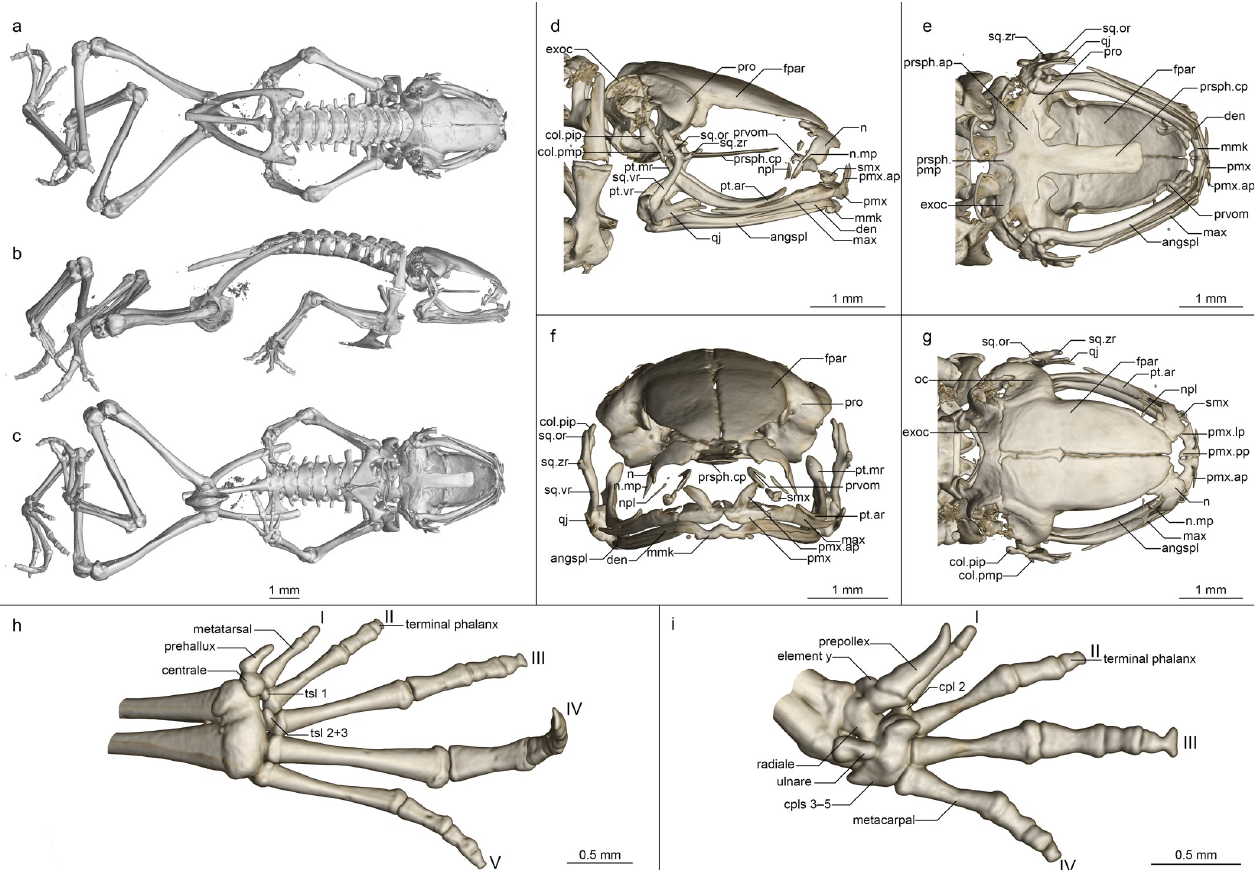
Fig 13. Osteology of Anodonthyla eximia sp. nov. holotype (ZMA 20246). (a-c) Whole skeleton in (a) dorsal, (b) lateral, and (c) ventral view. (d-g) Skull in (d) lateral, (e) ventral, (f) anterior, and (g) dorsal view. (h) Foot in ventral view. (i) Hand in ventral view. For abbreviations, see Fig 6. small, indistinct, single; inner metacarpal tubercle large and distinct, bulging outward strongly, underlain by cultriform prepollex; hand without webbing; all fingers short, first highly reduced and only marginally longer than the prepollex; relative length of fingers 1 < 2 = 4 < 3, fourth fin- ger equal in length to second; tip of third finger marginally expanded, other fingers not expanded into discs. Hind limbs robust; TIBL 39% of SVL; lateral metatarsalia strongly con- nected; inner metatarsal tubercle rounded, indistinguishable from first toe; outer metatarsal tubercle absent; no webbing between toes; first toe practically absent, second and fifth toes shortened; relative length of toes 2 < 5 < 3 < 4; fifth toe distinctly shorter than third. Skin on dor- sum smooth, without distinct dorsolateral folds. Ventral skin smooth. After 13 years in 70% ethanol, the dorsum is pale brown with a faint darker brown chevron over the scapular region (Fig 2). The dorsal legs have faint dark brown crossbands, especially on the shanks. The dorsal colouration fades over the shanks to cream, which is continuous on the venter. The lateral head is dark brown, with a distinct border to the dorsum and flank formed by the supratympanic fold. The chin is a lighter brown than the dorsum but distinctly not the cream of the abdomen. The ventral legs are translucent cream. Colour in life as in pre- servative but more vibrant; the venter was slate grey with blue-cream flecks. Bioacoustics. Calls recorded from an unknown specimen by M. Vences at 08h45, on 26 January 2004 at Maharira in Ranomafana National Park (21.3258˚S, 047.4025˚E, 1248 m a.s.l.)